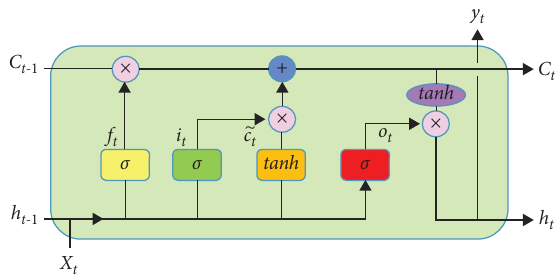
Figure 2: The architecture of LSTM memory block.